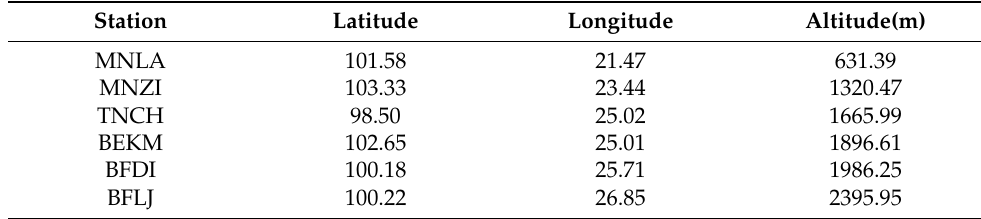
Table 1. Site coordinate information of GNSS/MET